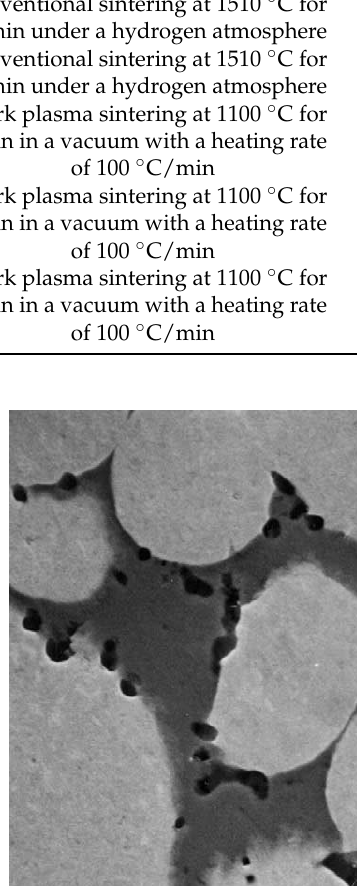
Figure 12. Variation in grain size in mechanically alloyed and sintered W-5.6Ni-1.4Fe with in- creasing Y 2 O 3 content [80]. Reproduced with permission from Ryu et al., Materials Science and Engineering: A; published by Elsevier, 2003. The compression test was carried out at 800 o C to study the deformation behavior of the alloy at elevated temperatures. The test showed a satisfactory result with an im- provement in the compression strength as the oxide content was increased. The alloy was able to maintain the oxide dispersion strengthening effect even at high temperatures. Another investigation by Fan et al. [82] with an yttrium-oxide-dispersed tungsten heavy alloy showed good tensile strength as well as good ductility with the addition of a low percentage of the oxide. Fine-grained alloys were prepared using a mechanical alloying process by dispersing 0.02–0.08 wt% of Y 2 O 3 into 90W–7Ni–3Fe in a ball mill for 40 h at 200 rpm, which resulted in composite powder with a size of 21.4 nm. The sintering was done at 1480 °C for 30 min under a hydrogen atmosphere. All the oxide-dispersed sam-